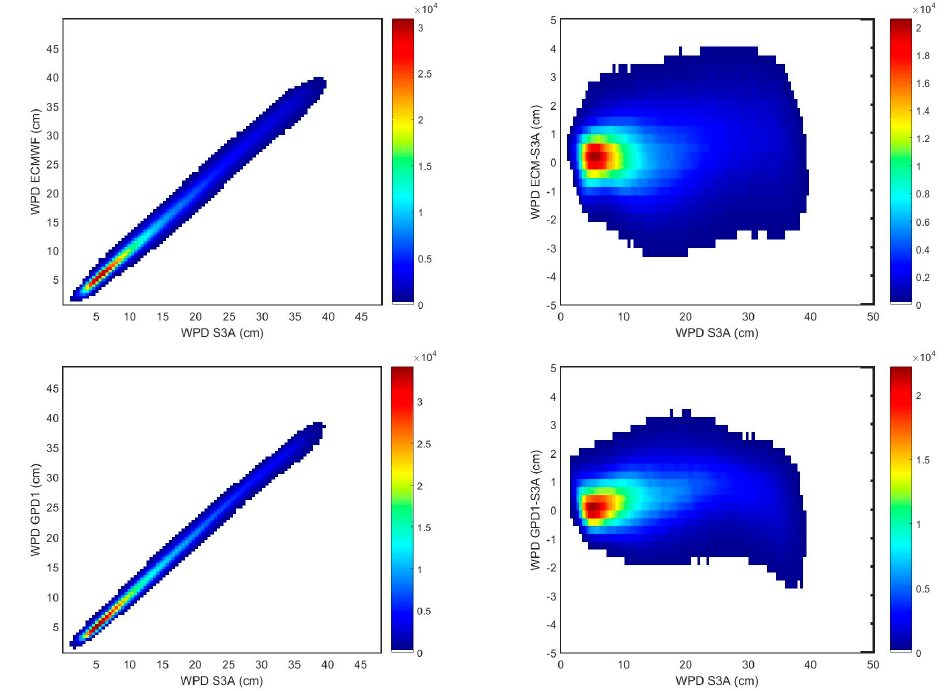
Figure 16. ( Left panels ): WPD from S3A versus WPD from ECMWF ( top ) and GPD1 ( bottom ), in cm; ( Right panels ): WPD from S3A versus WPD difference between ECMWF and S3A ( top ) and between GPD1 and S3A ( bottom ).